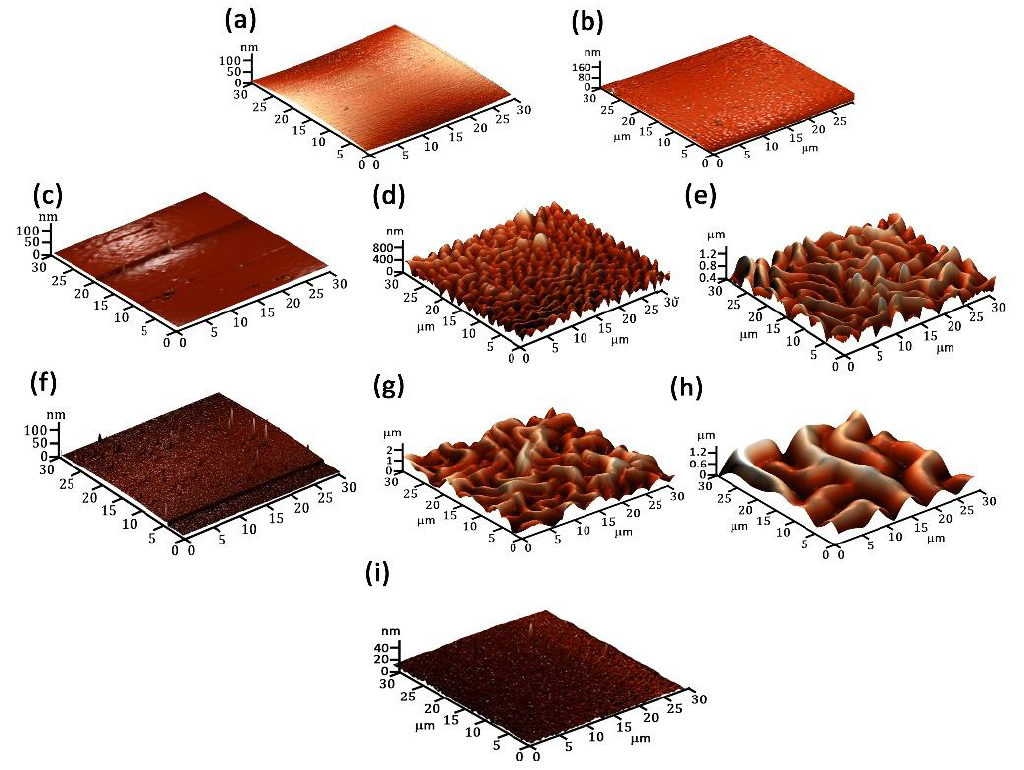
Figure 3. 3D images of: ( a ) PANI 1; ( b ) PANI 2; ( c ) PANI 3; ( d ) PANI 4; ( e ) PANI 5; ( f ) PANI 6; ( g ) PANI 7; ( h ) PANI 8; and ( i ) POA polymeric layers.